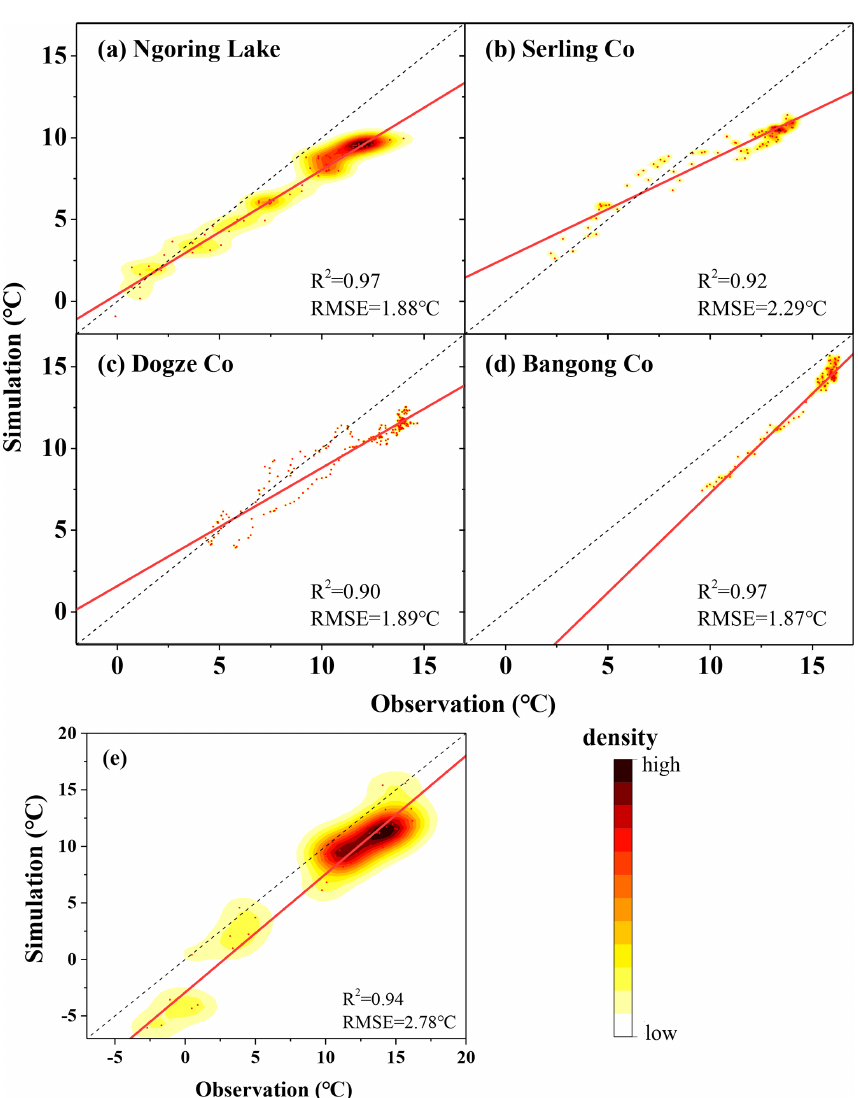
Figure 6. Validation of modeling results against in situ observation summarized in Table S1: (a) – (d) is the temporal validation for the four lakes with sequential observation; (e) is the spatial validation for the 41 lakes with sporadic observation. The solid lines are the regression lines. The dashed lines are the 1 : 1